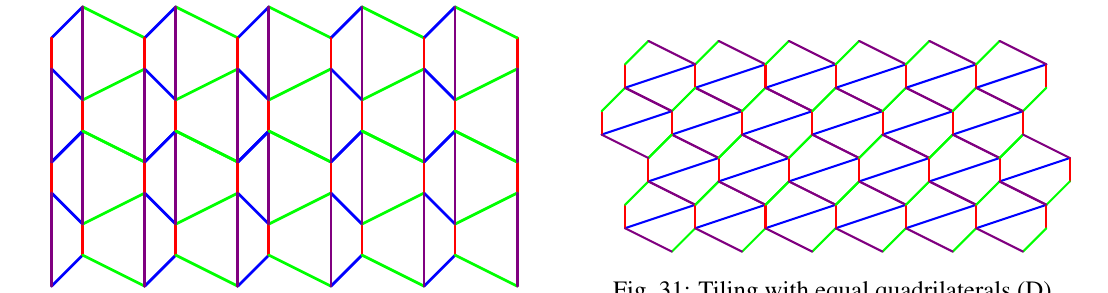
Fig. 30: Tiling with two types of trapezoids.